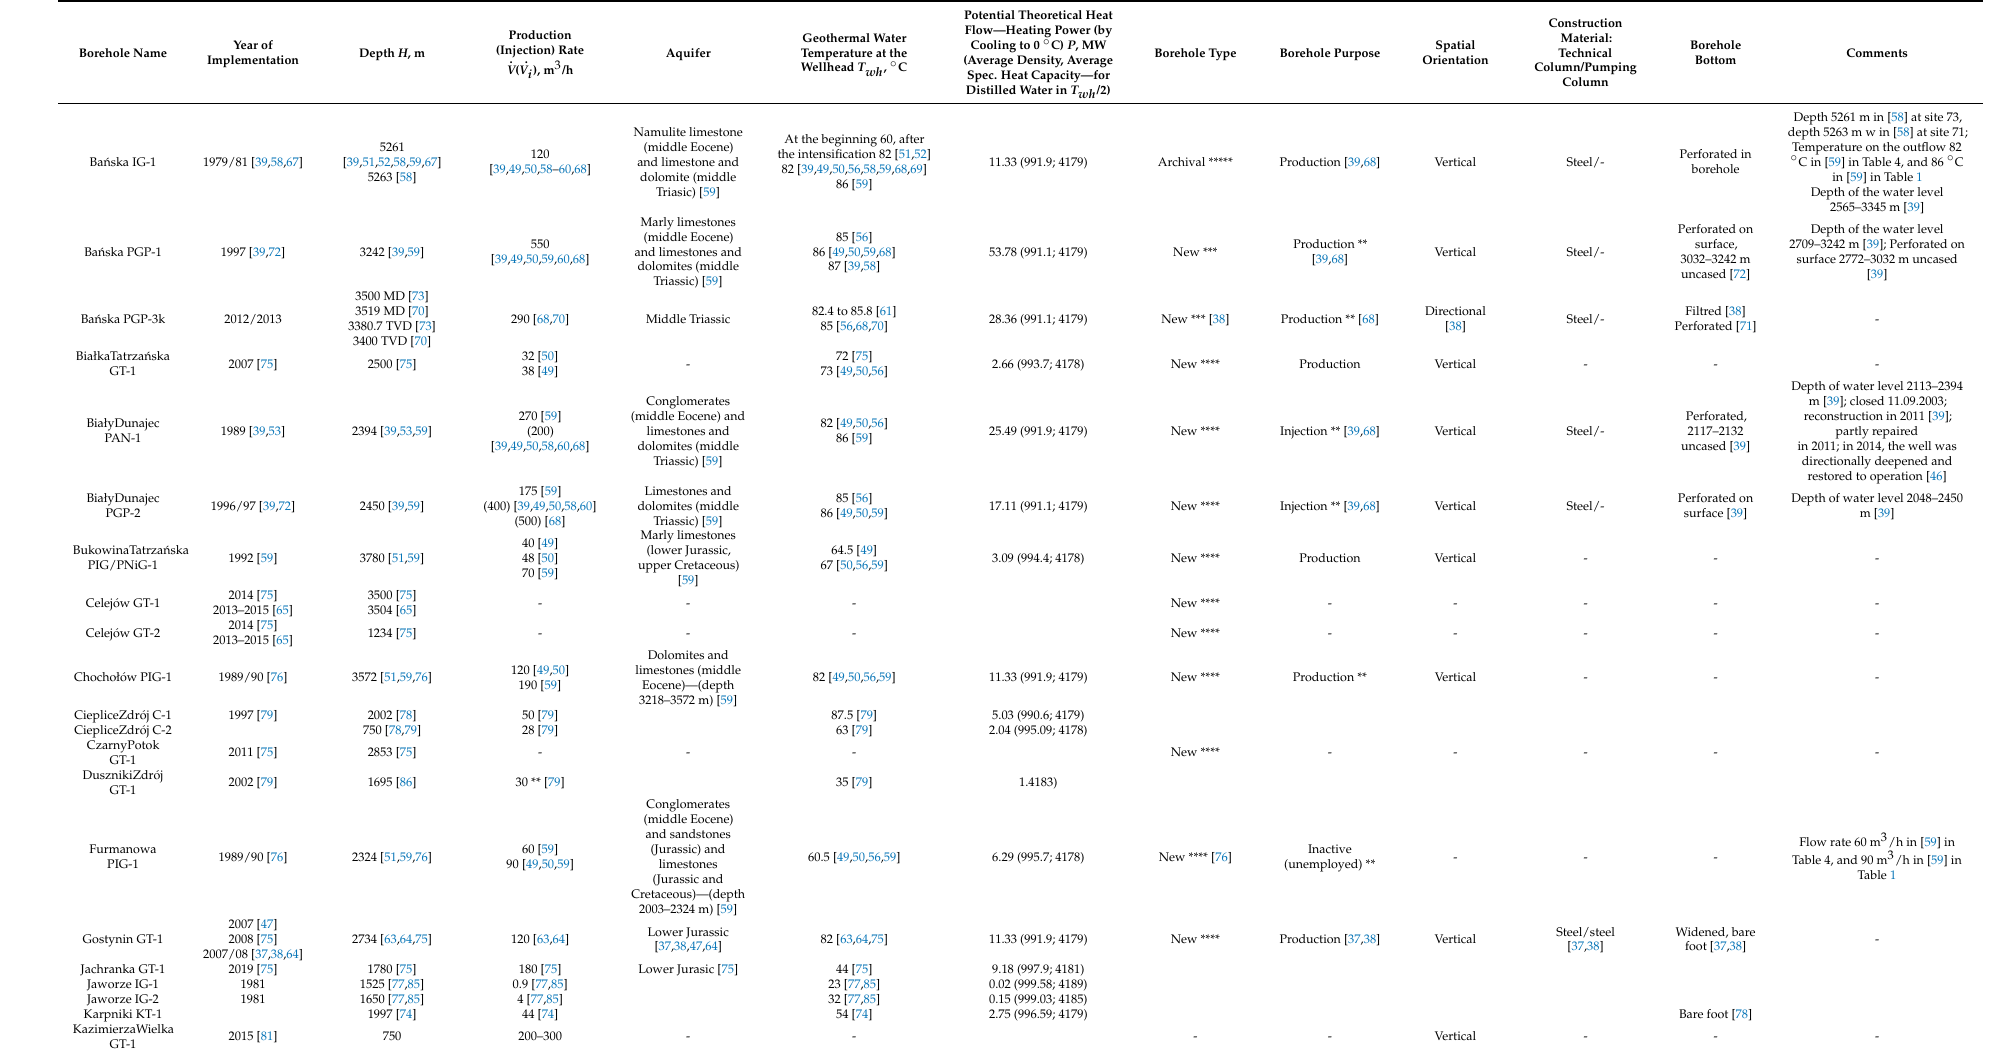
Table 1. Collective data on geothermal borehole parameters in Poland (based on